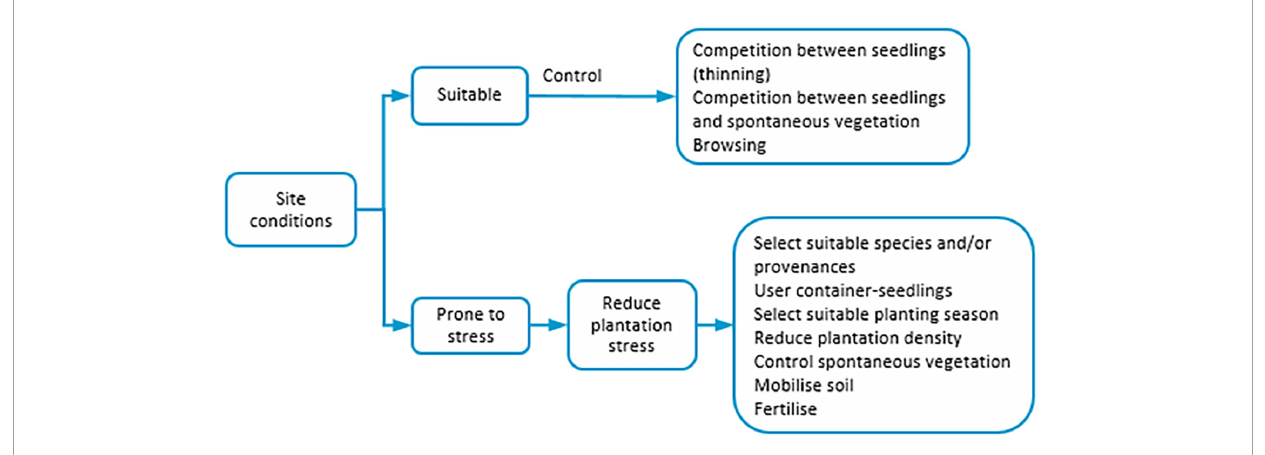
FIGURE4 Factors influencing